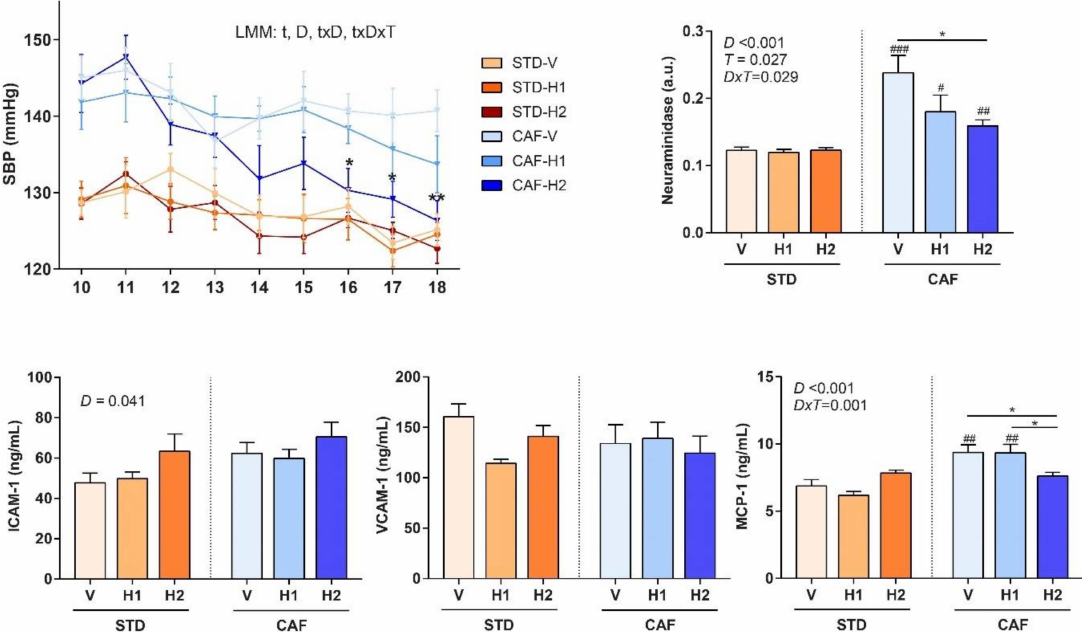
Figure 3. Systolic blood pressure (SBP) and end point (week 18) endothelial function parameters of rats that were fed with a standard (STD) or a cafeteria (CAF) diet and received a daily oral dose of vehicle (V), hesperidin at 40 mg / kg (H1), or hesperidin at 100 mg / kg (H2), for the last 8 weeks. Data are given as means ± SEM. D , Diet e ff ect; DxT , diet-treatment interaction; ICAM-1, Intercellular Adhesion Molecule 1; LMM, linear mixed model; MCP-1, Monocyte Chemoattractant Protein 1; T , treatment e ff ect; t, time e ff ect; VCAM-1, Vascular Cell Adhesion Molecule 1. # p < 0.05, ## p < 0.01, ### p < 0.001 vs the corresponding supplementation group in the STD diet model. * p < 0.05, ** p < 0.01 vs the V group in the same dietary